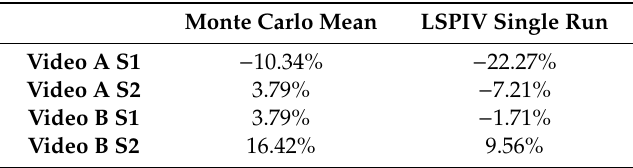
Table 3. Relative error of the estimated discharge.